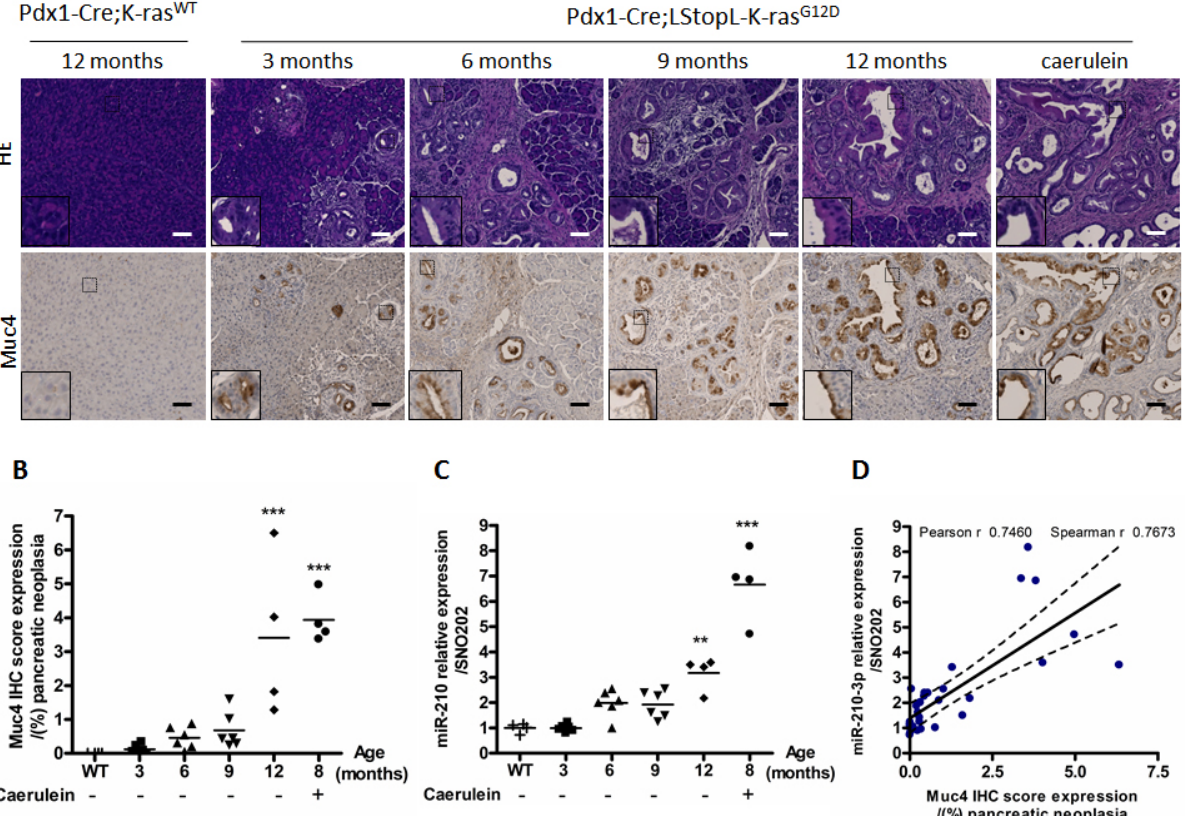
Figure 2. MiR-210-3p expression is correlated with Muc4 expression in PanIN lesions. ( A ) Hematoxylin and eosin stainings (upper panel) and Muc4 immunohistochemical staining (lower panel) were performed in pancreatic tissues from Pdx1-Cre; LStopL-K-rasG12D (KC) (3, 6, 9, 12 months and 8-month-old caerulein-treated mice) and Pdx1-Cre; K-rasWT (WT) control mice (12 months), representative of six mice per age. Scale bar: 100 µm. ( B ) An immunostaining score of Muc4 expression was calculated in PanIN lesions from KC mice treated, or not, with caerulein. *** indicates statistical significance ( p < 0.001) compared to WT mice. ( C ) miR-210-3p relative expression level was evaluated by RT–qPCR in PanINs pancreatic tissue from KC mice treated or not with caerulein and K-ras WT control mice. Data are expressed according to the 2 − ∆∆ Ct method ( ΔΔ Ct = (Ct miR-210-3p—Ct SNO202)—Ct K-rasWT). MiR-210-3p expression in WT control mice was arbitrarily set to 1. ** p < 0.01, *** p < 0.001 indicates a statistical significance compared to WT mice. ( D ) Correlation analysis between miR-210-3p expression and Muc4 expression in PanIN lesions. Statistical analyses were performed using Pearson’s and Spearman’s correlation coefficients ( r = 0.7460, r = 0.7673, respectively, p < 0.0001).